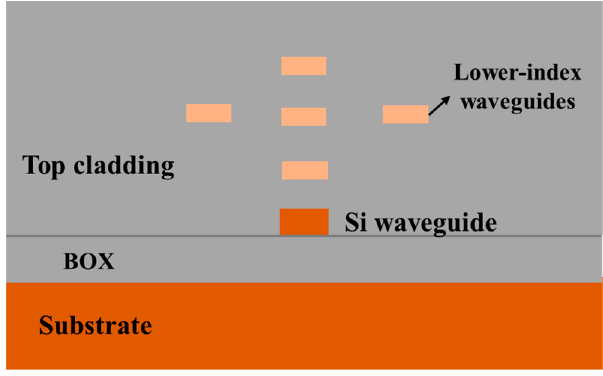
Figure 10. Silicon inverse taper assisted with multiple waveguides (cross-section view).